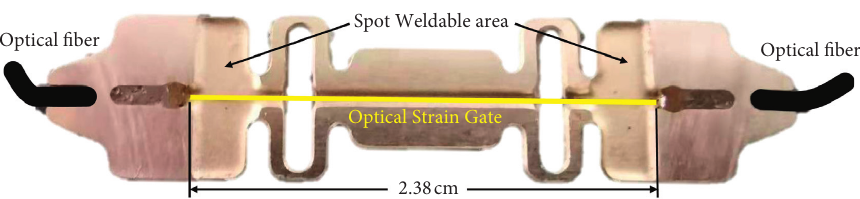
Figure 1: FBG principle.